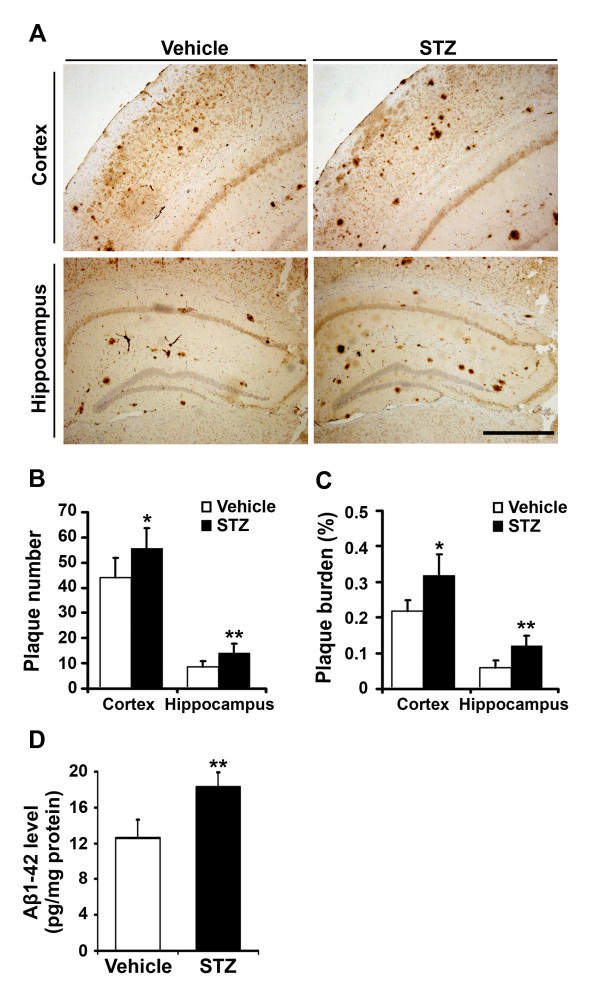
STZ-induced insulin deficiency accelerates plaque formation and Aβ secretion in the APP/PS1 mouse brain. (A) Twenty weeks after STZ administration, the senile plaques were detected using Aβ immunohistochemistry, and Aβ levels were measured by ELISA in APP/PS1 transgenic mouse brain. The representative images of Aβ-immunostained brain sections from vehicle control and STZ-treated transgenic mice, respectively. Note the number and size of Aβ-positive plaques were increased in the cortex and hippocampus in STZ-treated mice, compared with the control. Scale bar = 100 μm. (B) STZ-induced insulin deficiency significantly increased the number of plaques in the cortex and hippocampus in the transgenic mouse. (C) Insulin deficiency led to an increase in the plaque burden in the cortex and hippocampus of the mouse brain. (D) The level of soluble Aβ1-42 was measured using an ELISA kit. STZ treatment significantly increased the levels of Aβ1-42 peptide in APP/PS1 transgenic mouse brain. * p < 0.05, ** p < 0.01 (n = 7).